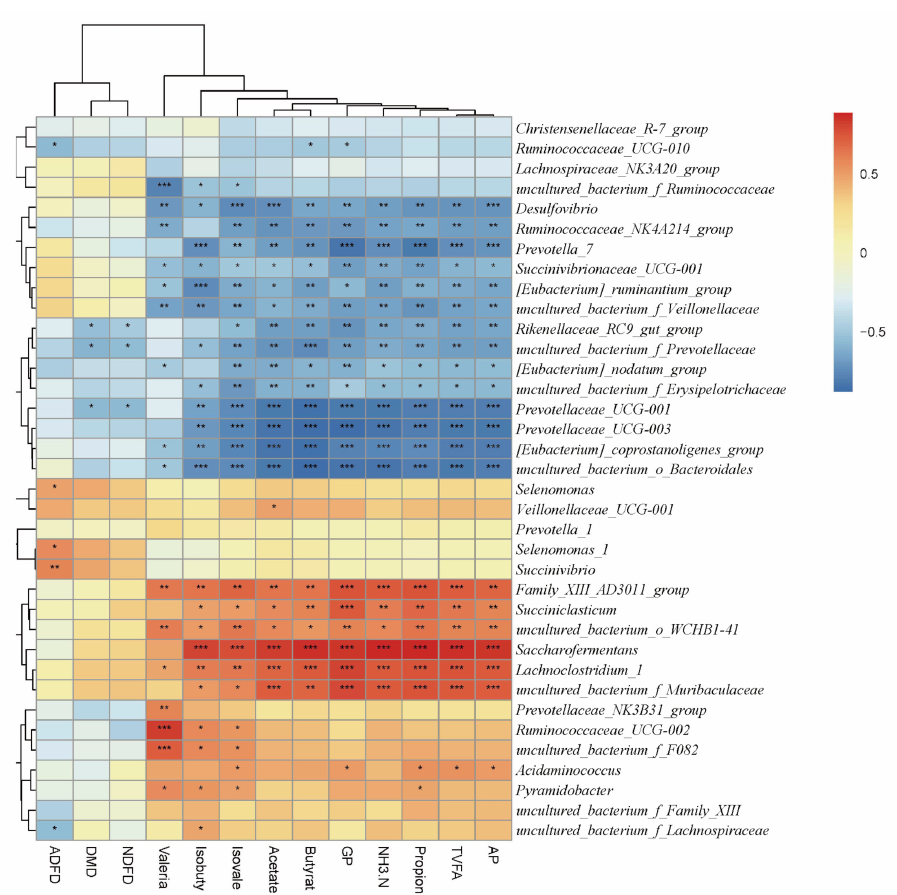
Figure 4. Significantly different bacterial taxa identified by the linear discriminant analysis effect size (LEfSe).